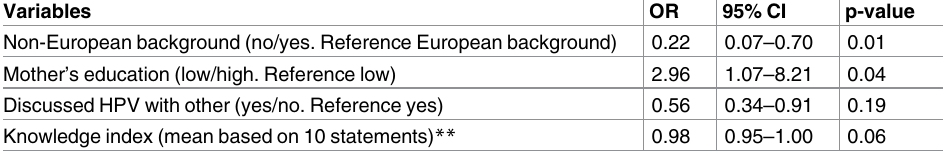
Table 6. Multivariate logistic regression models of variables associated with HPV * vaccination among